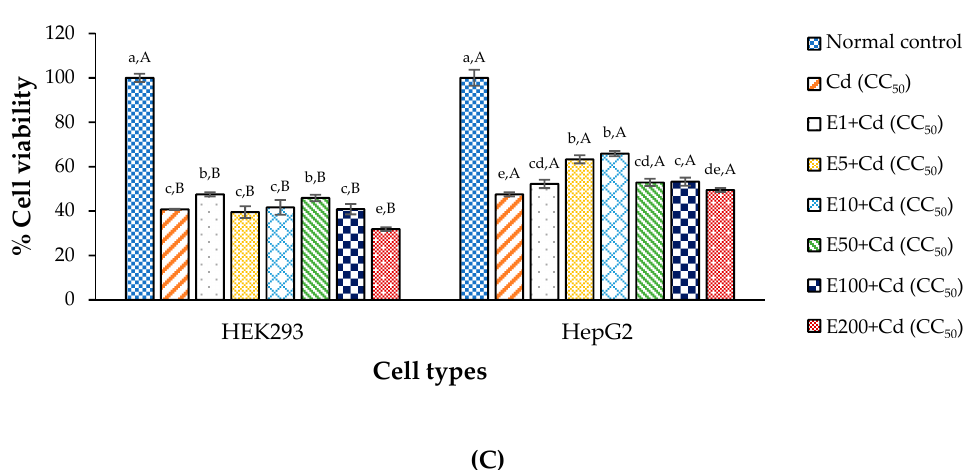
Figure 4. Anti-Cd toxicity of CaNa 2 EDTA in HEK293 and HepG2 cells determined by MTT assay; ( A ) combined-treatments; ( B ) pre-treatment and ( C ) post-treatment with CDE; a–g means with different letters are significantly different within a cell type ( p < 0.05); A,B means within an extract concentration with different letters are significantly different ( p < 0.05); E means CaNa 2 EDTA solution (µg/mL); Values are mean ± standard deviation.